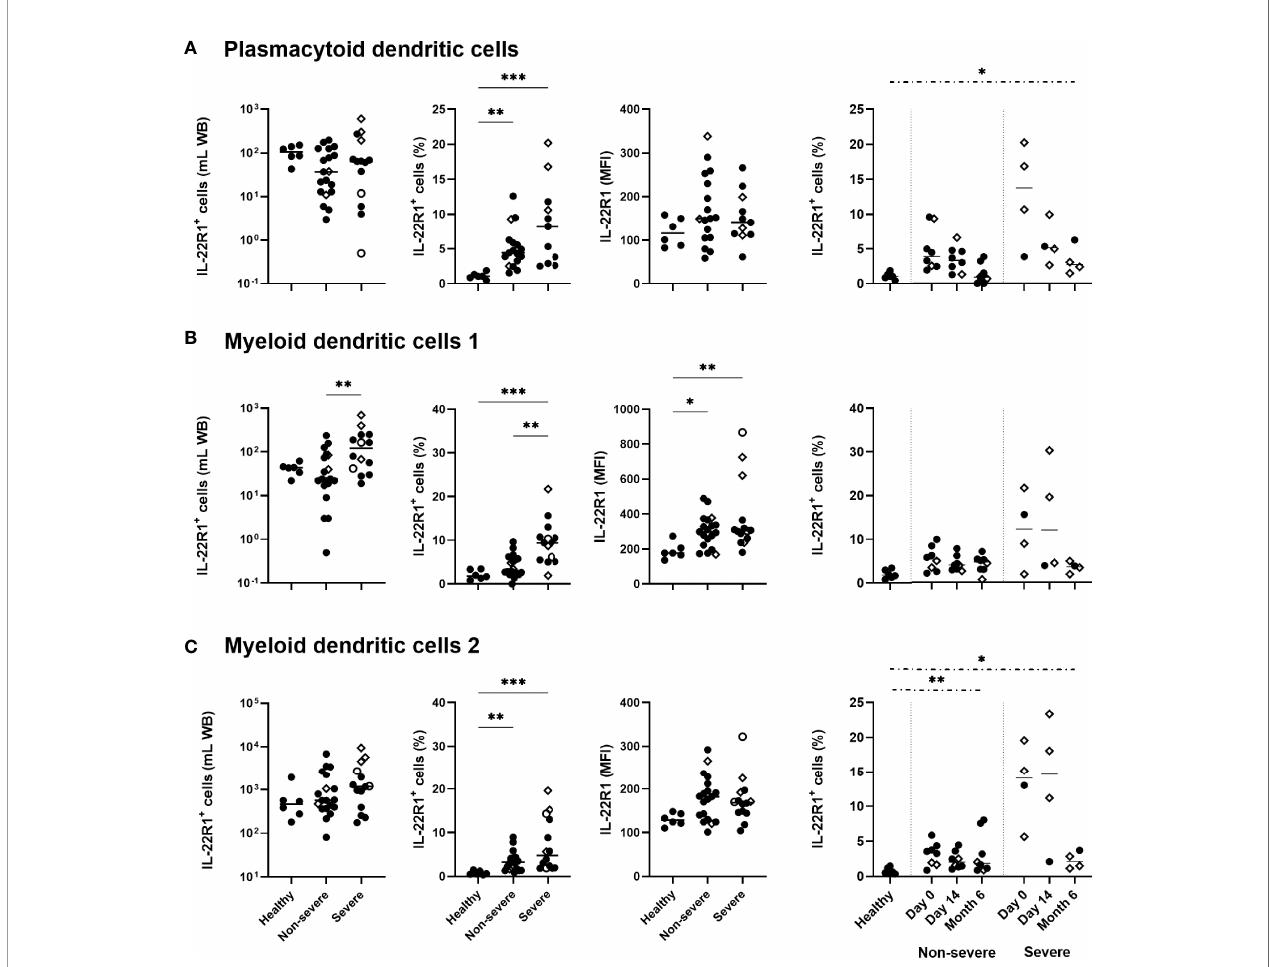
FIGURE 3 | IL-22R1 expression on human blood dendritic cell (DC) subsets in COVID-19 patients compared to healthy controls. Absolute cell numbers, percentages of the IL-22R1 + cells and median fl uorescence intensity of IL-22R1 on (A) plasmacytoid DC, (B) myeloid DC1 and (C) myeloid DC2 are shown in healthy controls (n=6), non-severe (n=19) and severe (n=14) COVID-19 patients at day 0. Kinetic analysis of the percentages of IL22R1 + cells over time is represented for COVID-19 patients on the right panels at D0 and 14 days (11 non-severe, 9 severe) and six months (8 non-severe, 4 severe) later. The patients who died from COVID-19 are represented on the graphs as empty circles, and the patients who declared long-term COVID-19 at their 6 months follow-up (2 out of 8 non-severe and 3 out of 4 severe cases) are represented on the graphs as empty diamonds. The horizontal bars indicate the medians of the results within each column. The statistical analyses were performed by Kruskal Wallis test to compare results from the different groups of subjects at D0, and by Mann Whitney U test to compare patient ’ s results at Month 6 to controls. Signi fi cant differences are shown as * p <0.05, ** p <0.01, *** p <0.001. Time point comparisons at D0, D14 and Month 6 restricted to paired samples were performed by Friedman test and the numbers of IL-22R1 + pDC cells were lower at 6 months compared to D0 in non- severe patients ( p